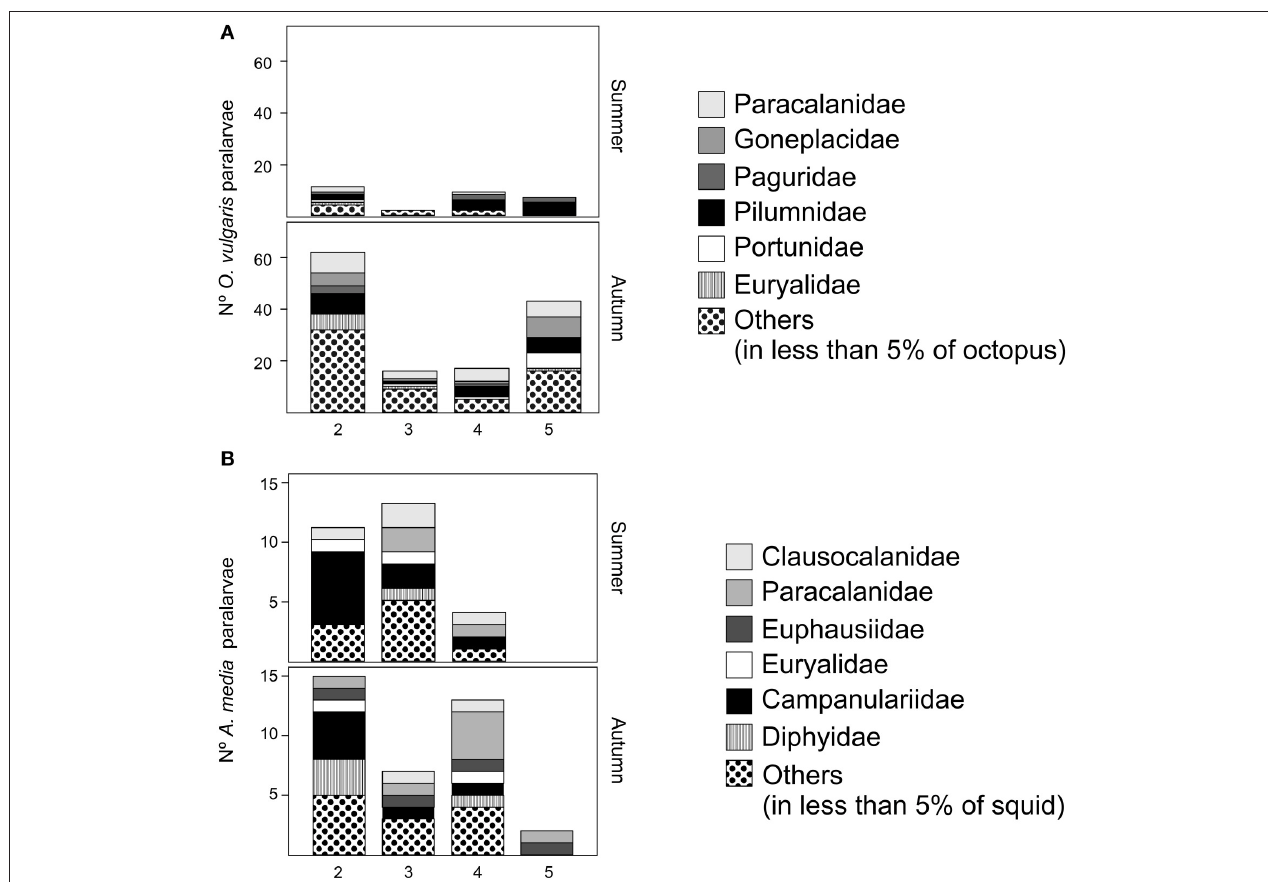
FIGURE 6 | Families detected in O. vulgaris paralarvae (A) and A. media paralarvae (B) in different transects (2, 3 4, 5) and different seasons (summer, autumn). The vertical axis represents the number of paralarvae that present a given